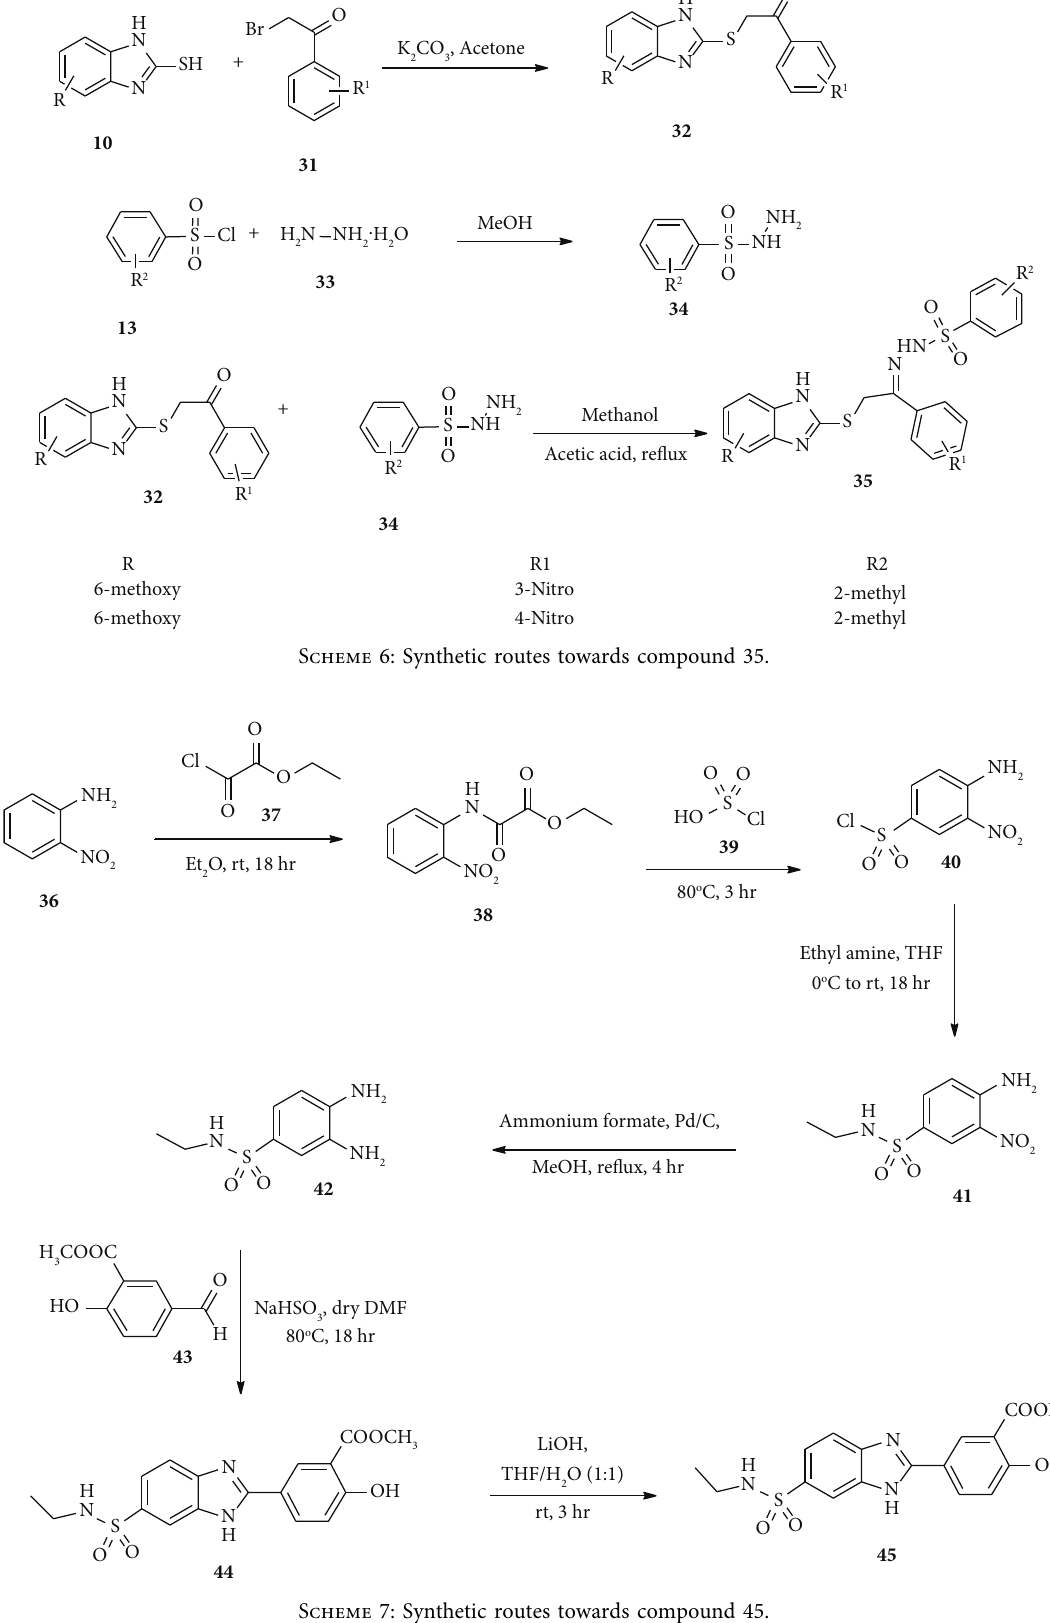
Scheme 7: Synthetic routes towards compound